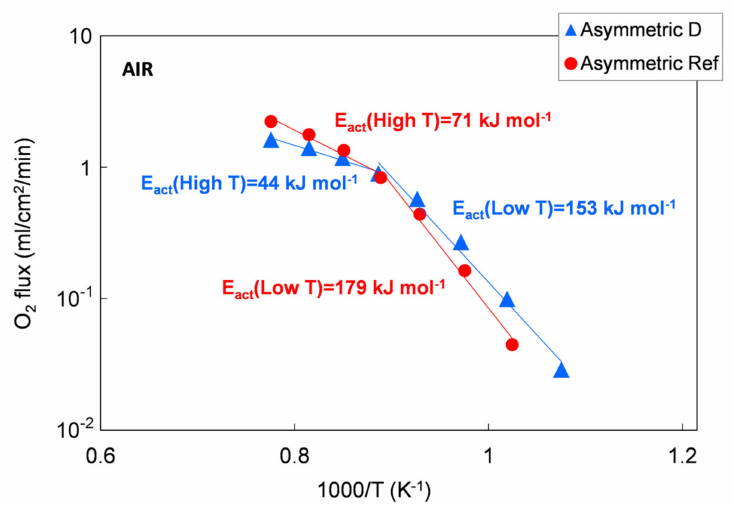
Figure 14. Oxygen flux as a function of temperature. Results of permeation tests performed on a membrane manufacture with the reference powder and with the Praxair powder (D) selected in this